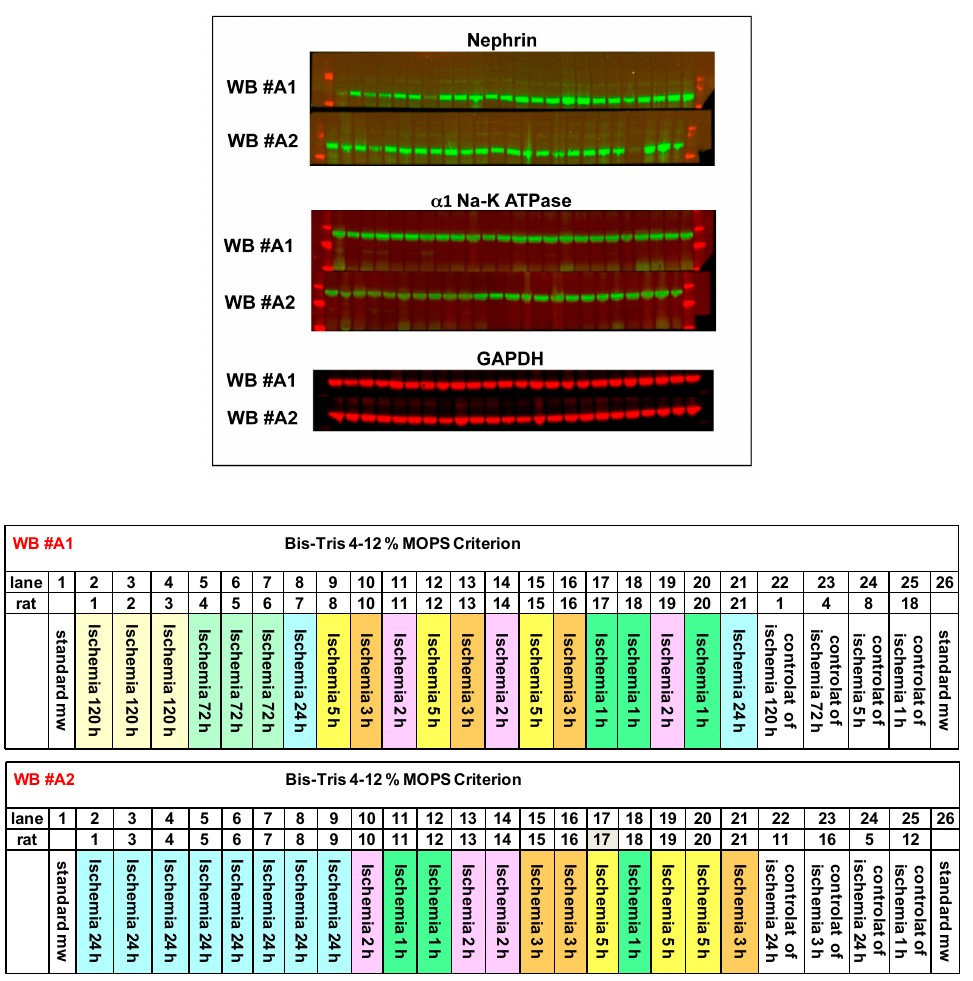
Figure 2. Representative images of the Western blots for nephrin and α 1 Na-K ATPase of the time course experiment. GAPDH was used as loading control. Standards of molecular weight are shown on the left and right in red (for nephrin: 250, 150 kDa; for Na-K ATPase: 100, 75, 50 kDa). Two gels are shown: WB #A1 and WB #A2 (26 wells). Lane legends are shown in the lower panel, each lane representing one rat.